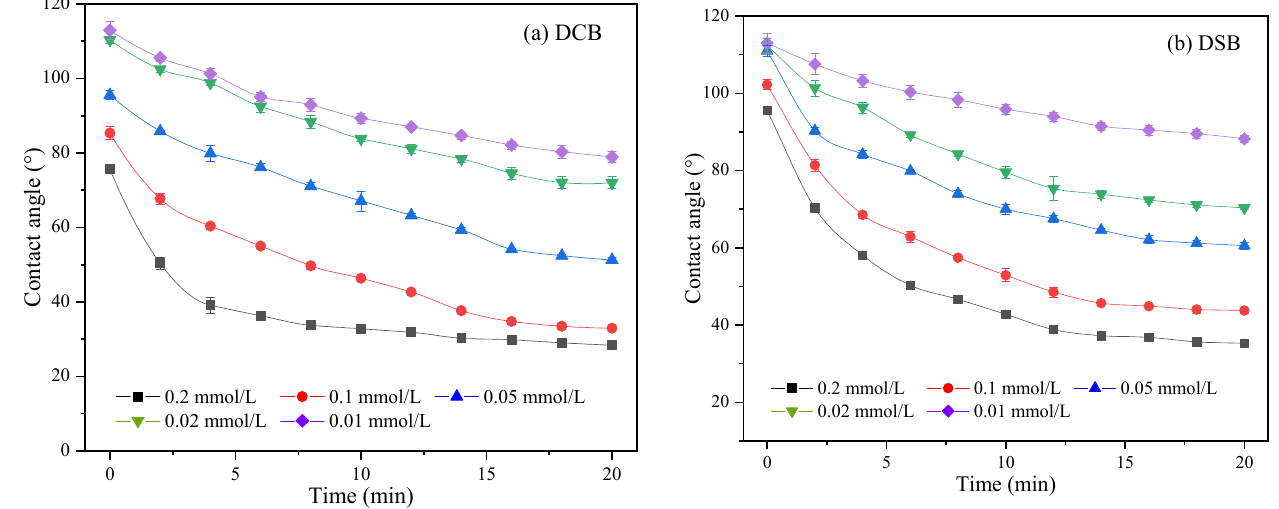
Figure 7. Variation of the contact angle with different surfactant concentrations on the paraffin surface at 25 °C for DCB ( a ) and DSB ( b ).